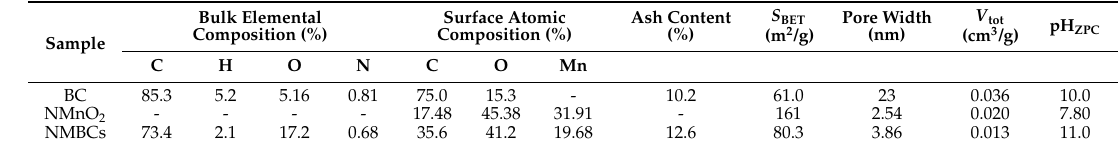
Table 1. Selected physiochemical properties of the BC, NMnO 2 , and NMBCs.